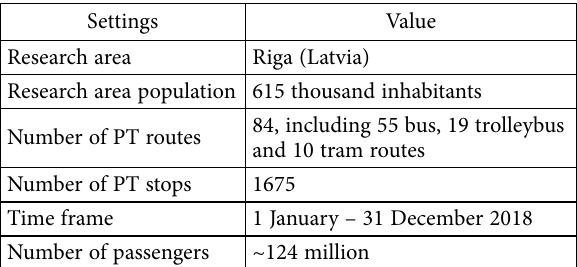
Table 1. Description of the research area and data set